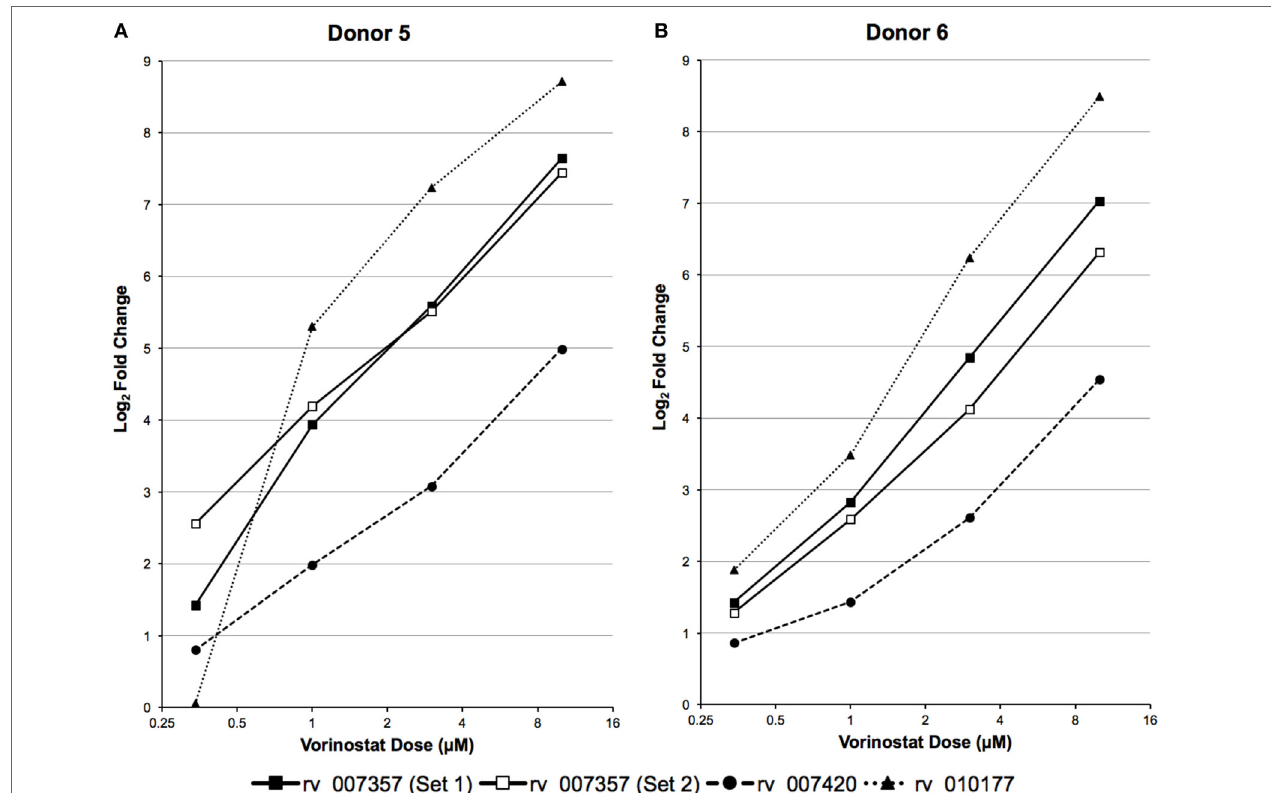
FigUre 4 | LTR12 elements are upregulated by vorinostat in a dose responsive manner. LTR12 expression was measured by droplet digital PCR using log 2 fold changes between each dose of vorinostat (0.34, 0.1, 0.3, and 10 μ M) and the untreated control as calculated for (a) Donor 5 and (b) Donor 6. The labels “Set 1” and “Set 2” indicate the two distinct primer and probe sets used to target the same LTR12 element (i.e., rv_007357). LTR12 elements are labeled with their “rv” designation according to the Human Endogenous Retrovirus